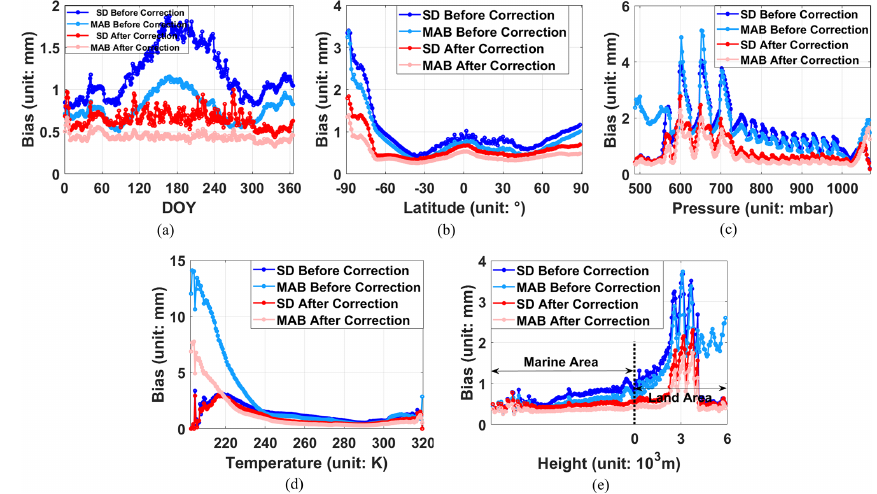
Figure 12. The MABs and SDs of biases in different dimensions before and after correction over 2021. Panel (a) represents the global MABs and SDs on different DOYs, (b) represents the MABs and SDs at different latitudes, (c) represents the MABs and SDs in regions with different air pressures, (d) represents the MABs and SDs in regions with different temperatures, and (e) represents the MABs and SDs in regions with different heights. Table 4. Statistics of systematic biases before/after correction in different months and the whole year of 2021 (unit: mm). Month Min bias Max bias MAB SD January − 9 . 28/ − 7 . 44 13.27/ 8.53 0.70/ 0.47 0.84/ 0.65